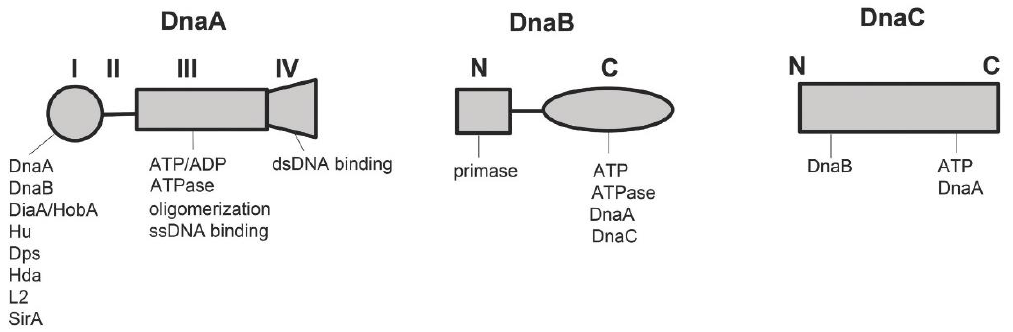
Figure 1. Functional regions of DnaA, DnaB and DnaC. The domain names are shown above the cartoons. Interacting proteins, cofactors and other functions of each domain are shown below the cartoon. See the text for